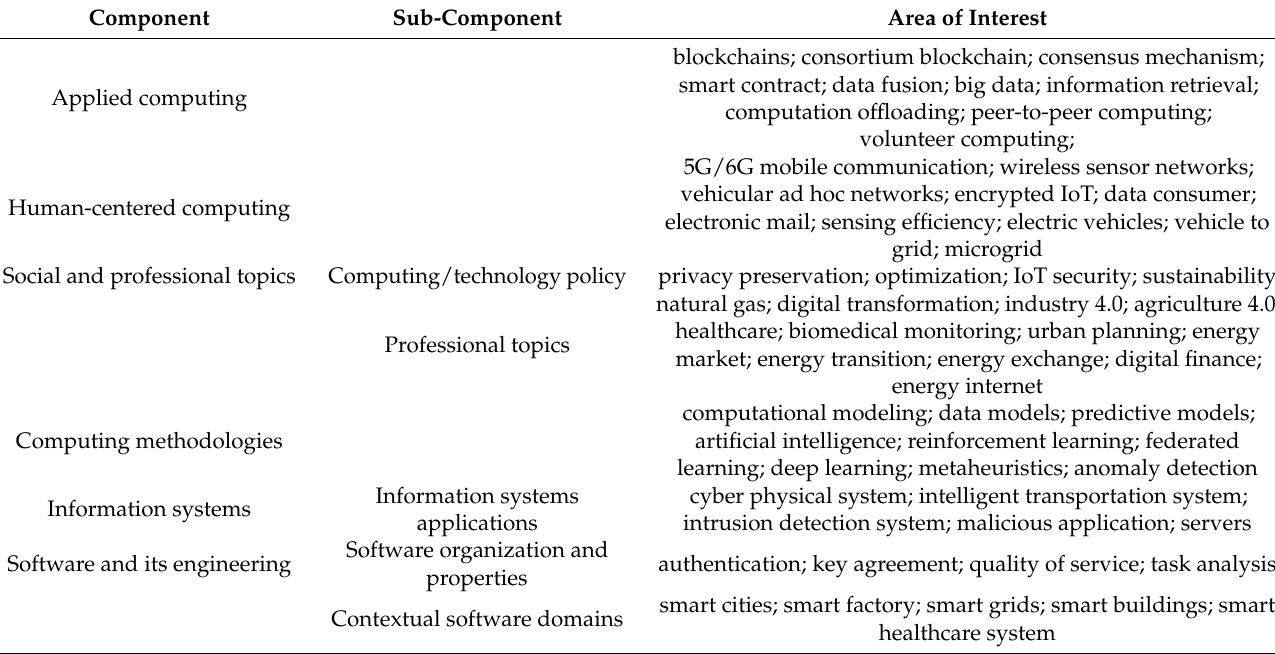
Table 9. Smart cities body of knowledge adapted from Fitsilis and Kokkinaki